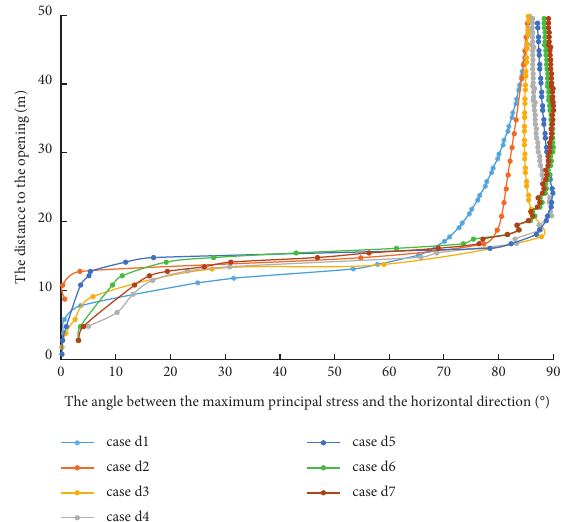
Figure 12: The relationship between the direction of the maximum principal stress and the distance to the opening.